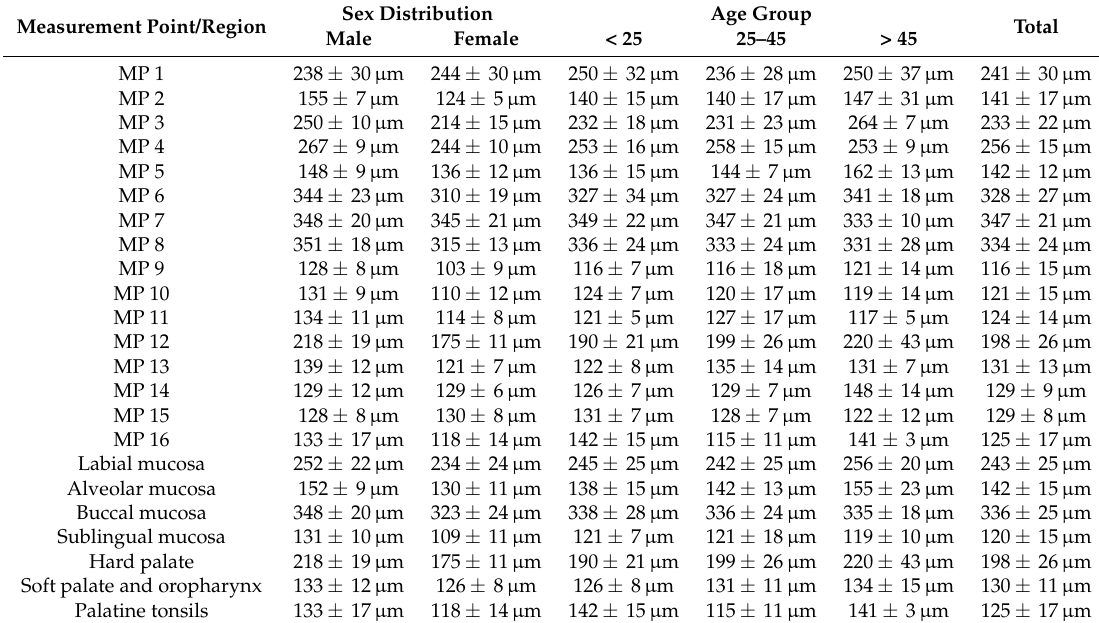
Table A1. Mean epithelial thickness ( ± standard deviation) of individual measurement points and defined regions adjusted by sex and age.